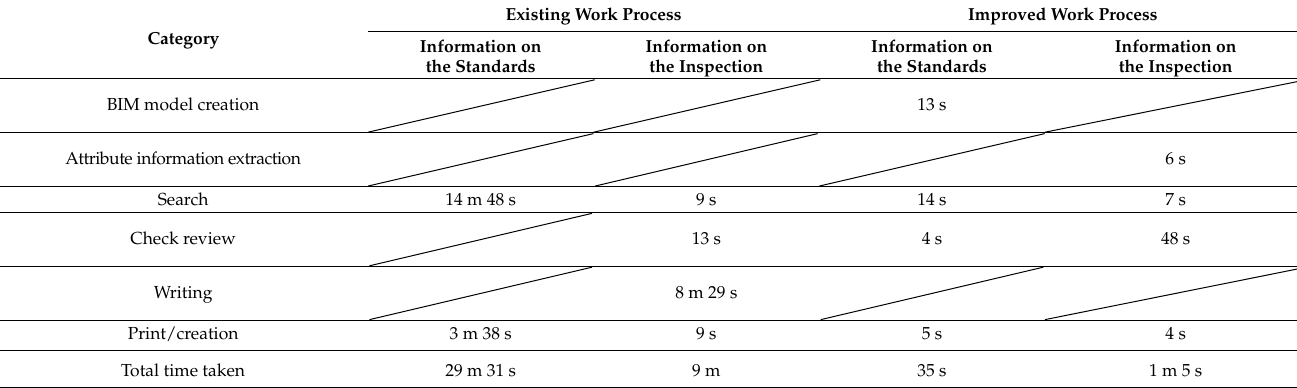
Table 8. Time measurement results by work process for pre-inspection works (second